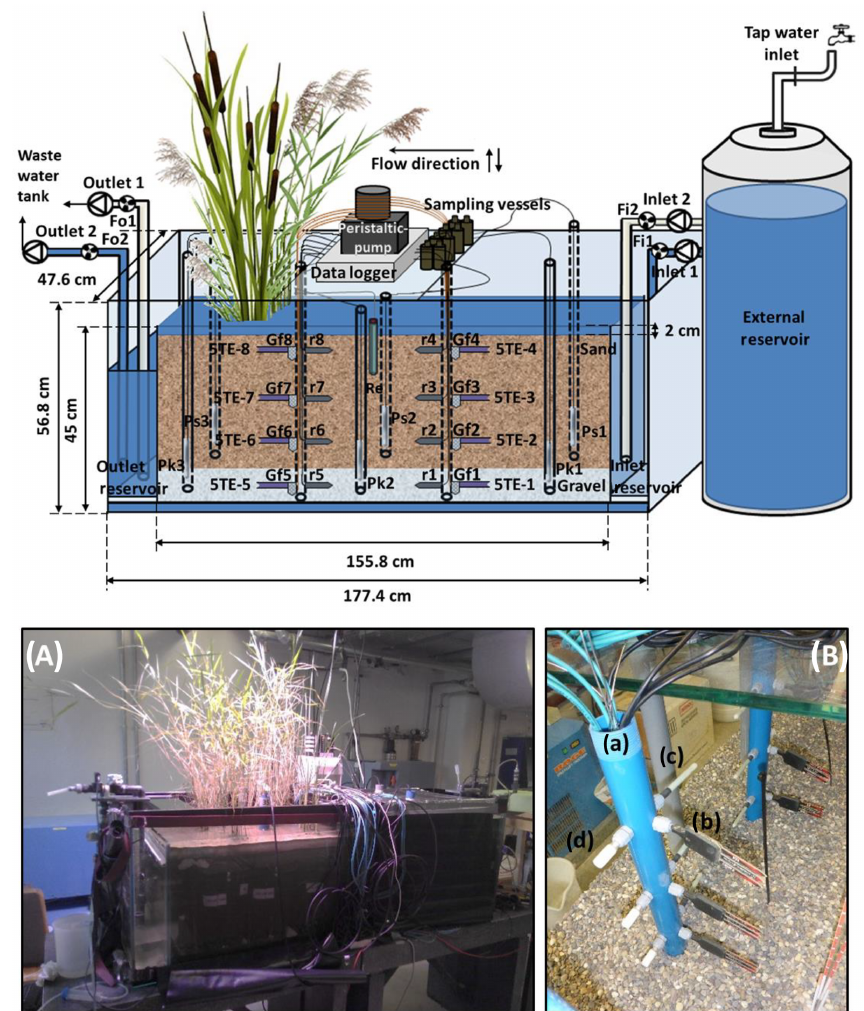
Figure 1. Schematic representation of the model constructed wetland system (not to scale). Fi1 and Fi2 indicate the flowmeters at the inlet; Fo1 and Fo2 indicate the flowmeters at the outlet; Ps(n) denotes a piezometer in the sand; Pk(n) denotes a piezometer in the gravel; 5TE-(n) denotes a soil moisture, temperature and electrical conductivity sensor; r(n) denotes a platinum redox electrode; Re is a reference electrode (Ag : AgCl); Gf(n) denotes a glass filter. For the piezometers, n indicates the position with respect to the inlet: n = 1 is close to the inlet, n = 2 is in the middle of the sediment bed and n = 3 is close to the outlet. For the sensors installed in the multilevel pipes, n indicates the zone and the depths where they are located: n = 1, 2, 3 and 4 refer to the non-vegetated zone at a depth of 39, 27, 15 and 3cm, respectively; n = 5, 6, 7 and 8 refer to the vegetated zone at a depth of 39, 27, 15 and 3cm, respectively. (A) Front view photograph of the model constructed wetland system. (B) Detail of the multilevel pipes: (a) multilevel pipe in the vegetated zone, (b) a 5TE sensor, (c) a redox electrode and (d) a glass